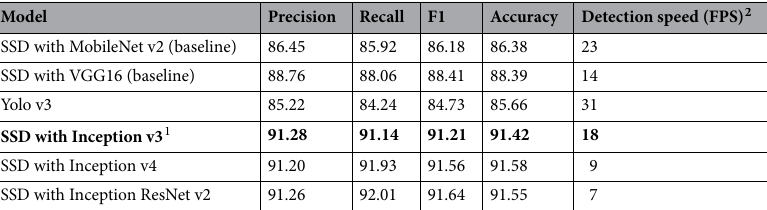
Table 4. Comparison analysis with baseline method and other object detection framework. 1 The bolded model is the framework used for real-time Raptor test. 2 This refers to the inference time (ms) required by the respective model for one image converted into frame per second (FPS) metric, all models were tested on the same hardware and a total of 300 images (100 for each class) during the comparison analysis.